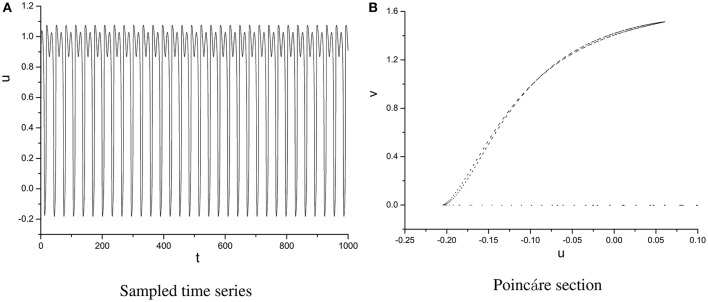
Sampled time series (A) and its Poincáre section (B) as ω = 0.4.